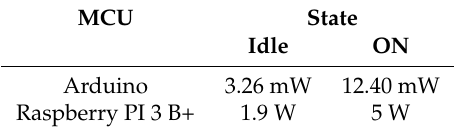
Table 7. Energy Consumption for different states and MCU used in our setup.